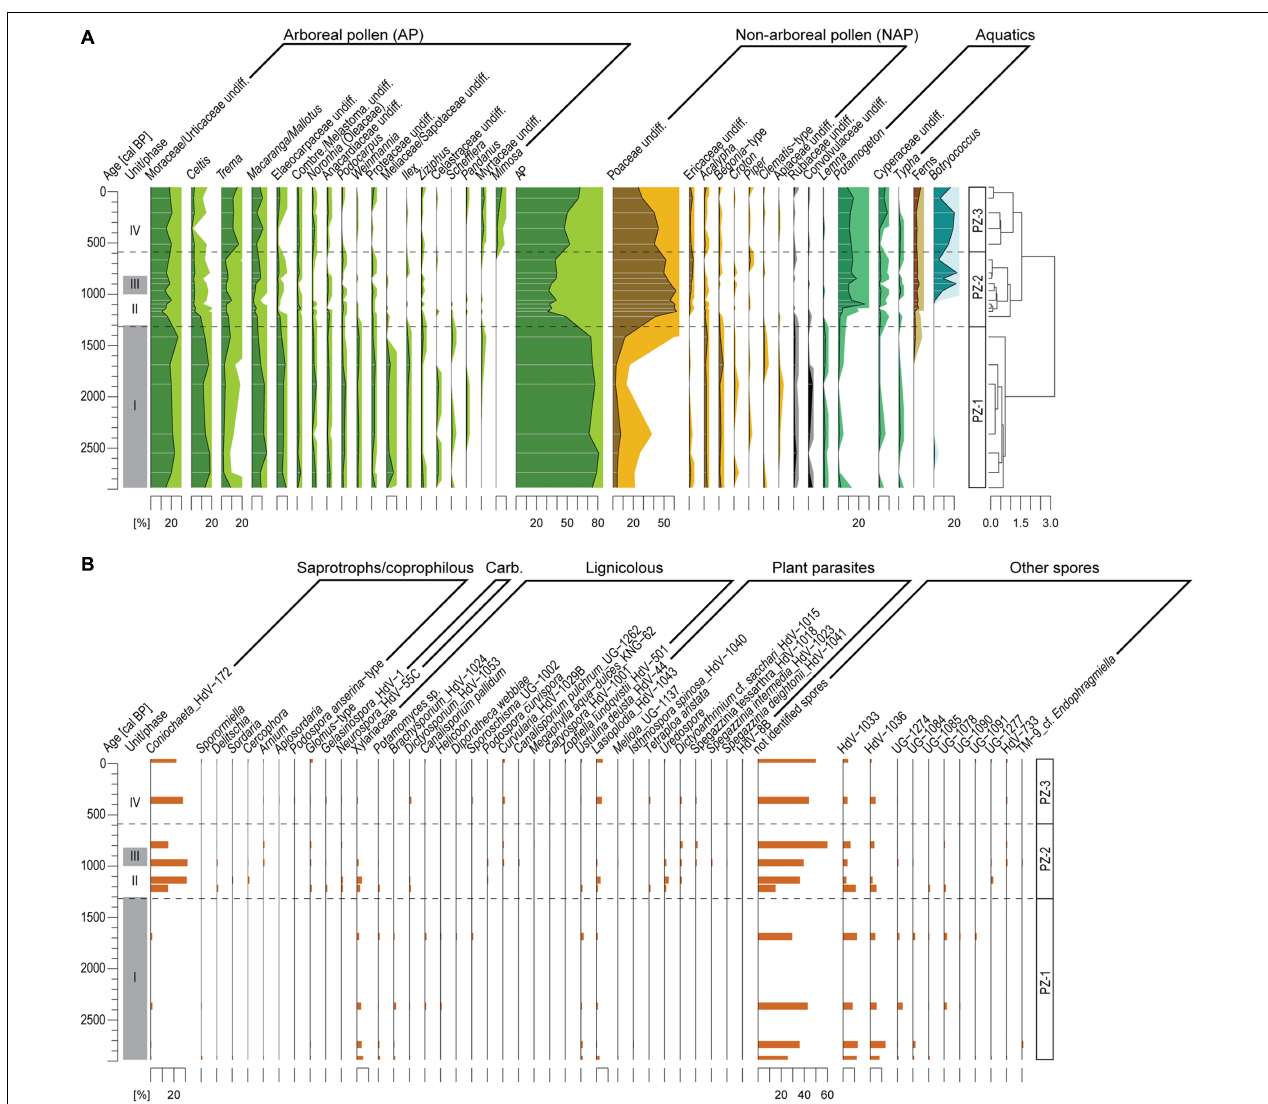
FIGURE 5 | (A) Pollen and fern spore records of composite record AMP16 retrieved from Lake Amparihibe (Nosy Be, Madagascar) plotted on an age scale. Percentages of pollen and fern spores were calculated on the terrestrial pollen sum. Pollen zone (PZ) indicated by dashed lines were identified by a cluster analysis (CONISS, Grimm, 1987). The light-colored pollen curves correspond to exaggerated curves by a factor 5. (B) Fungal spore record plotted on an age scale of composite record AMP-16. Percentages are calculated based on total count of fungal spores. Gray shaded areas demarcate sedimentological units.